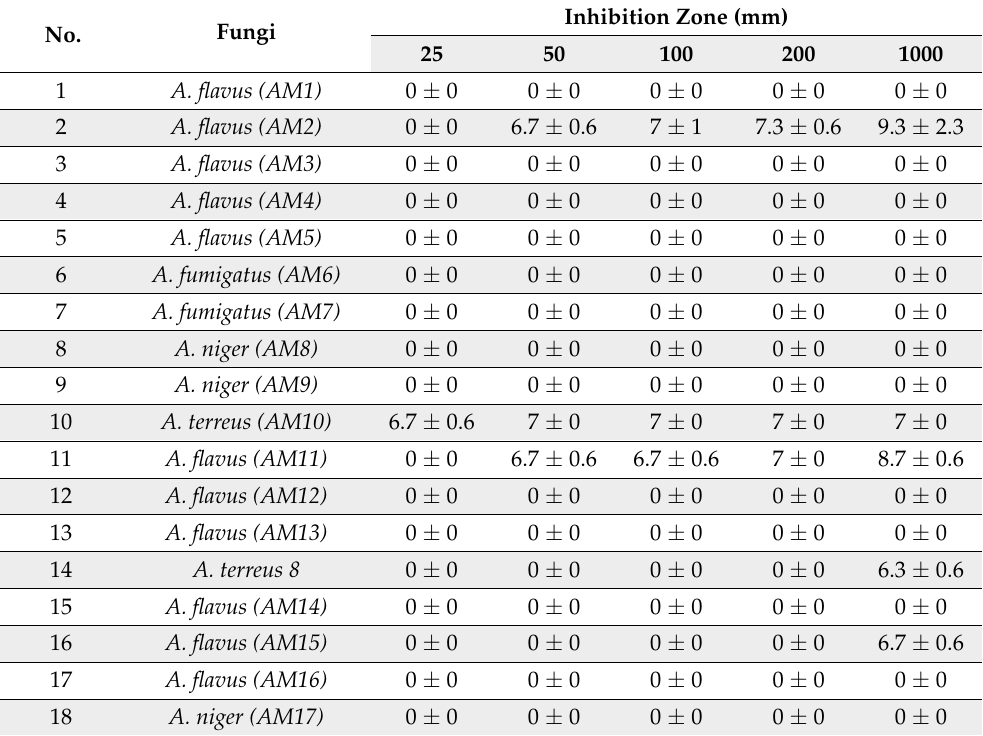
Table 8. Efficacy of different concentrations of AuNPs against fungi as the zone of inhibition in disc method.